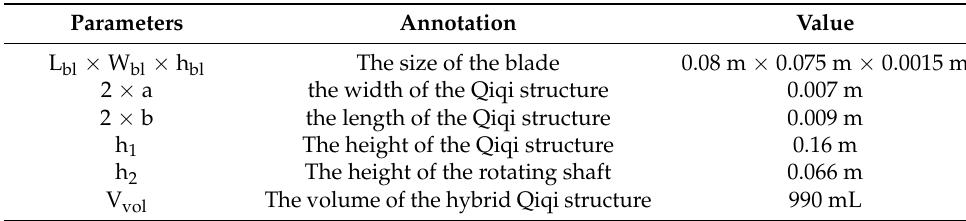
Table 1. Main parameters of the hybrid Qiqi